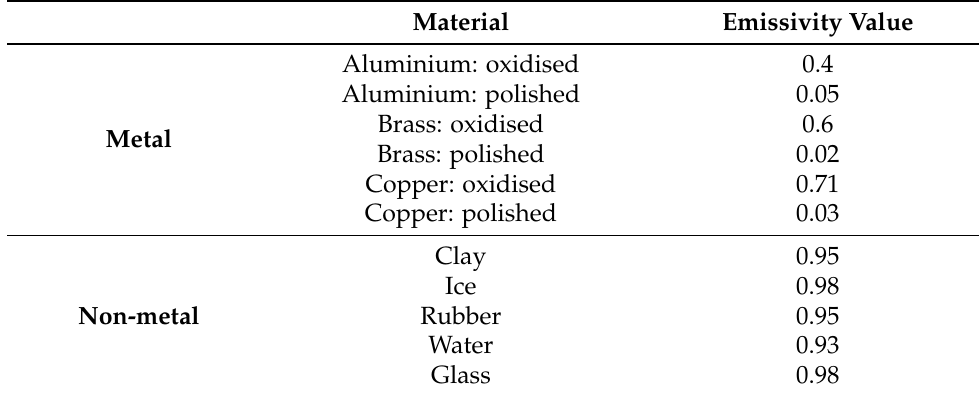
Table 2. Emissivity values for some materials [45].